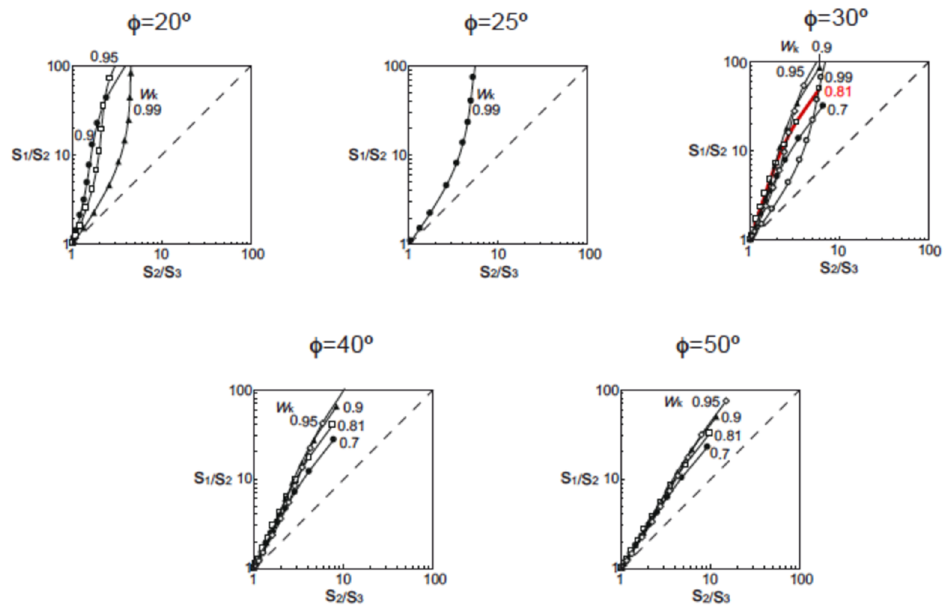
Figure 7. Logarithmic diagrams with the finite strain ellipsoid shapes for several predictions of the analytic model of transtension that show a good fit to the measured natural data. The results do not depend on the actual strike of the ESFZ (N90 ◦ E to N110 ◦ E) but mainly on ϕ and Wk. As an example, the trajectory depicted by the ellipsoid shapes from one of the most acceptable fits for a N100 ◦ E trending segment of the EFSZ ( ϕ = 30 ◦ W, W k = 0.81) is highlighted with a red